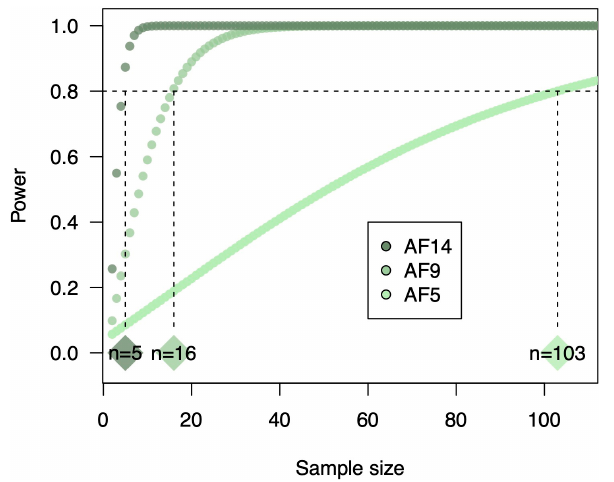
BOX FIGURE 1 | Power curves for responses of soil bacterial diversity to a chronosequence of agroforestry compared to wheat monocultures. The chronosequence included 5, 9, and 14 years of agroforestry (AF5, AF9, and AF14,